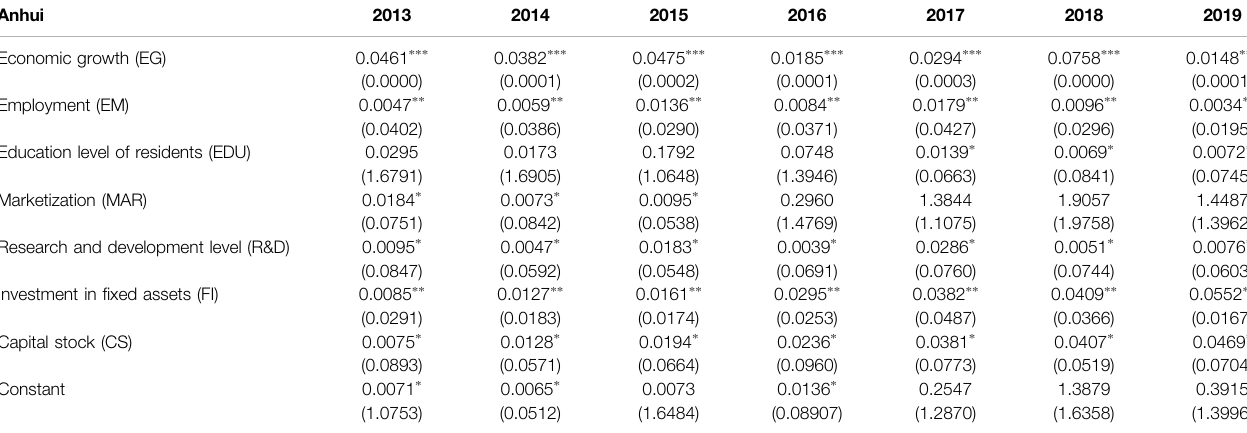
TABLE 9 | Driving force of Anhui health tourism industry convergence. Anhui